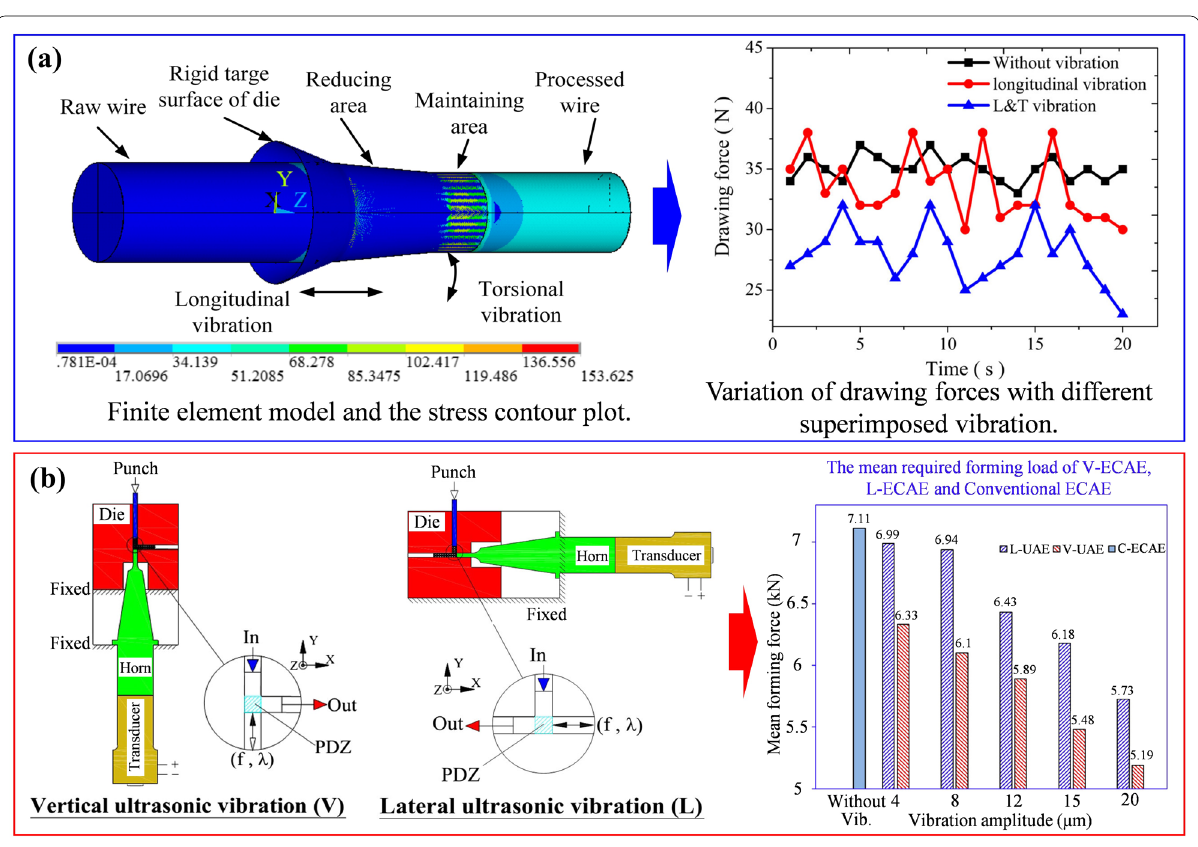
Figure 11 The influence of UV on forming force: a wire drawing [81]; b ECAP